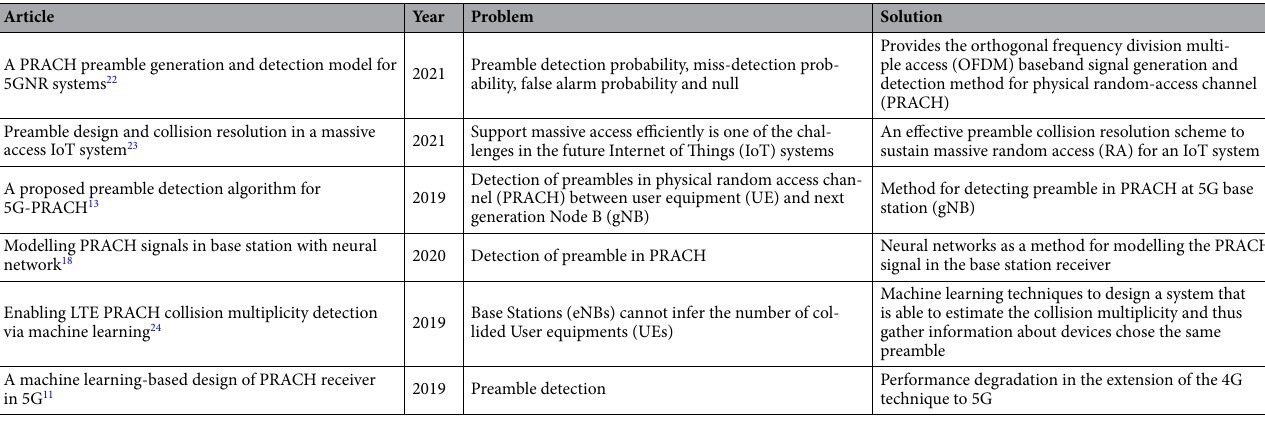
Table 2. Comparison with the existing state-of-art work.